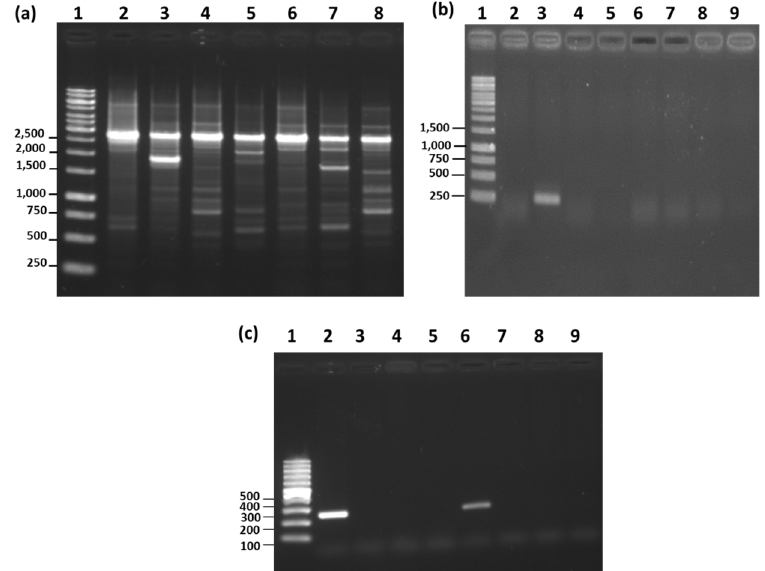
Figure 5. ( a ) RAPD-PCR of various reference strains of Bacillus thuringiensis. Lane 1: 1 kb size ladder